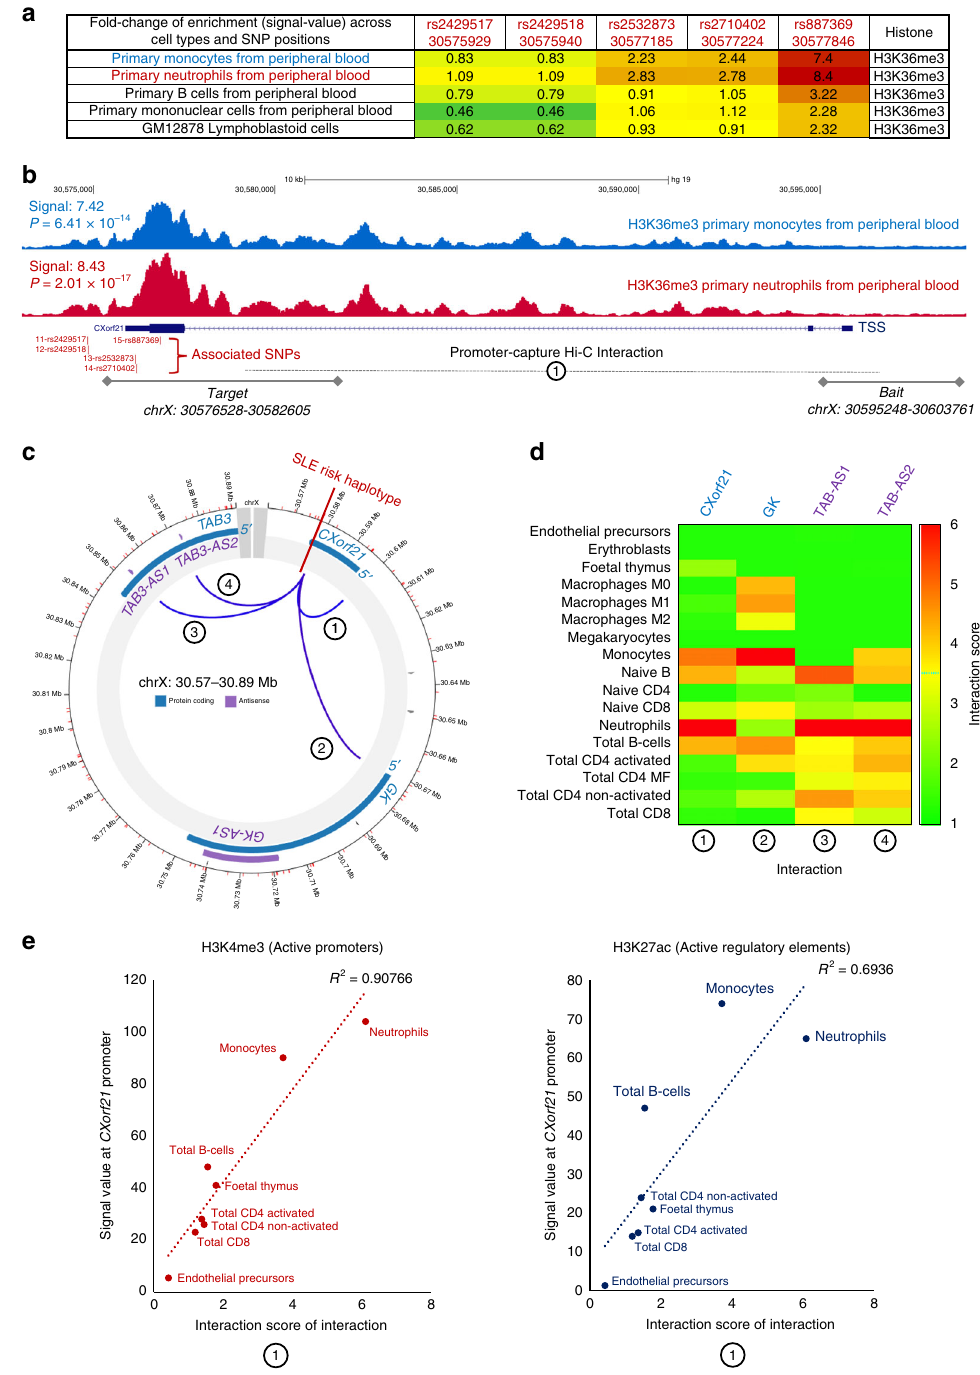
Fig. 3 Functional prioritisation of causal variants at the Xp21.2 SLE susceptibility locus. The fi ve SNPs carried on the risk haplotype attributed to SLE susceptibility and modulation of CXorf21 gene expression were epigenetically fi ne-mapped using chromatin data from the Roadmap Epigenomes Project (twelve different marks across 127 cell/tissue types). a The fi ve SNPs localised to signi fi cant H3K36me3 modi fi cation sites in fi ve immune cell types. The heatmap shows the fold-enrichment of H3K36me3 between cell-types across SNP positions. b Signal tracks of H3K36me3 in primary monocytes (blue) and primary neutrophils (red) from peripheral blood across the CXorf21 susceptibility locus. Only rs887369 localises to the binding site summit of H3K36me3 in these two cell types. c Promoter-capture Hi-C interaction of the rs887369 target locus (chrX :30576528 – 30582605) with four bait loci across 17 primary immune cell types from healthy human donors (Note that the majority of the samples are pooled from multiple donors making it impossible to deconvoloute the sex and genotypes of the individuals). Interaction #1 is the interaction between the association target region (at the 3 ′ end of CXorf21 ) and the CXorf21 promoter region. d Heatmap of strength of interaction (CHiCAGO score) of the four interactions across immune cell types. e Correlation of interaction score for interaction #1 (3 ′ of CXorf21 and CXorf21 promoter) with Roadmap Epigenomes Project chromatin marks found at the CXorf21 promoter across different immune cell types. Higher interactions are correlated with greater enrichment of active chromatin marks suggesting the interaction to regulate gene expression is cell-type speci fi